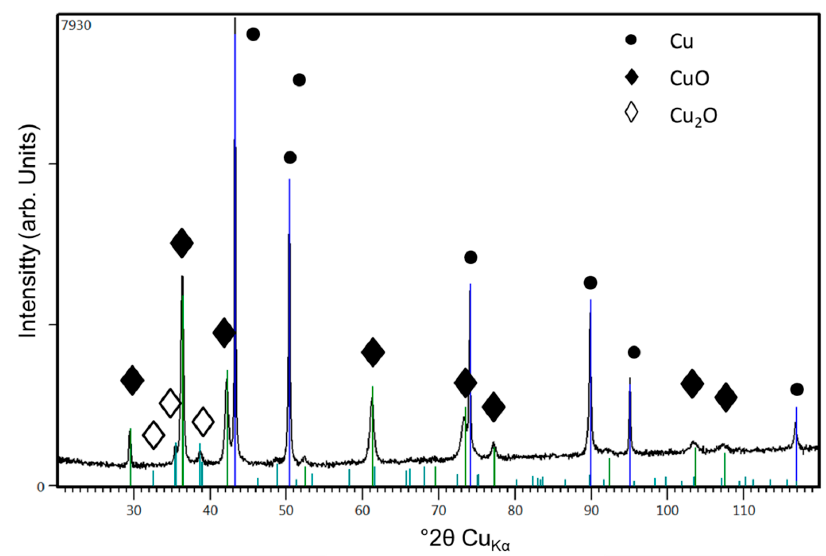
Figure 14. XRD spectrum of HVSFS sprayed Cu coating shown in Figure 12 on the left ( λ = 0.57; spray distance = 60 mm and total gas volume = 190 l / min). CuO and Cu 2 O. Strongest peaks are labeled.